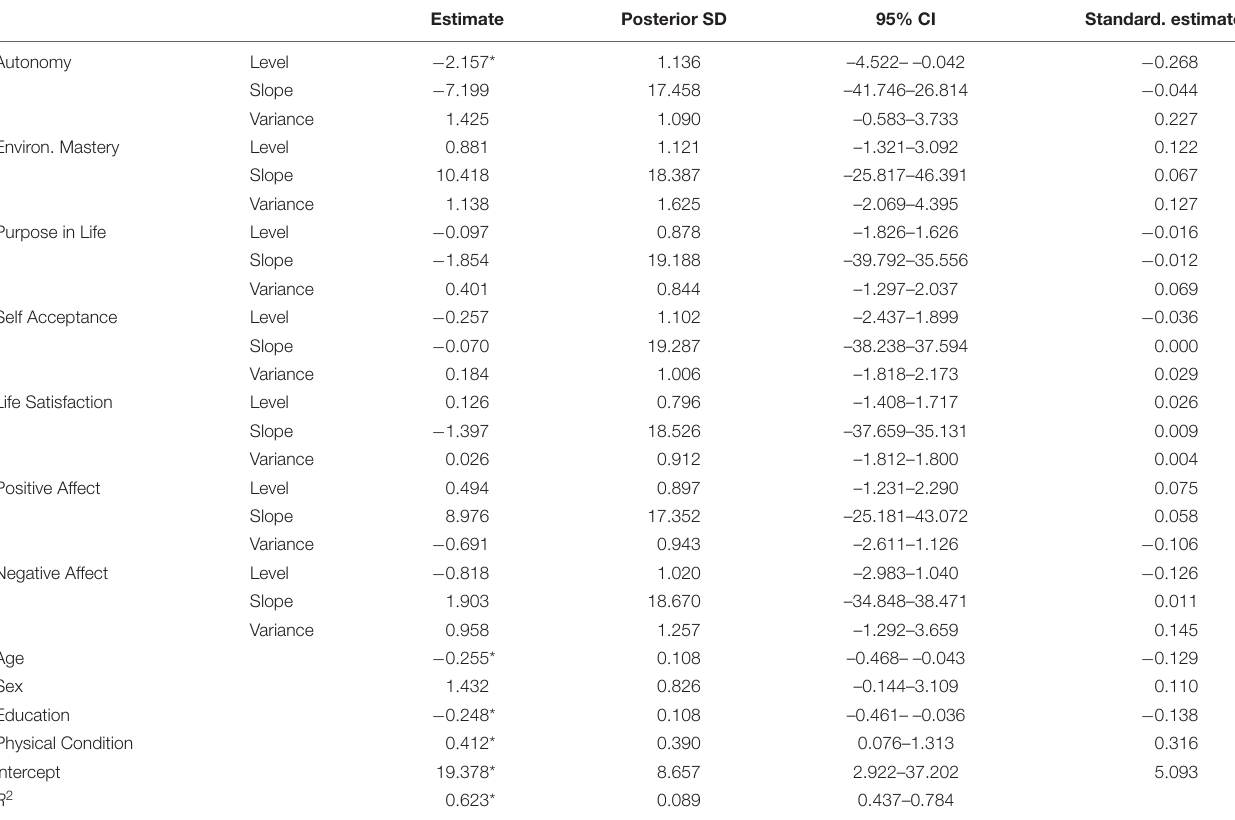
TABLE 5 | Multilevel SEM between-person regression of time-to-death at baseline and full model including all predictors. Estimate Posterior SD 95% CI Standard.